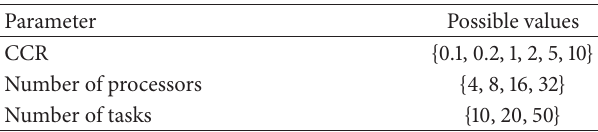
Table 10: Configuration parameters for random